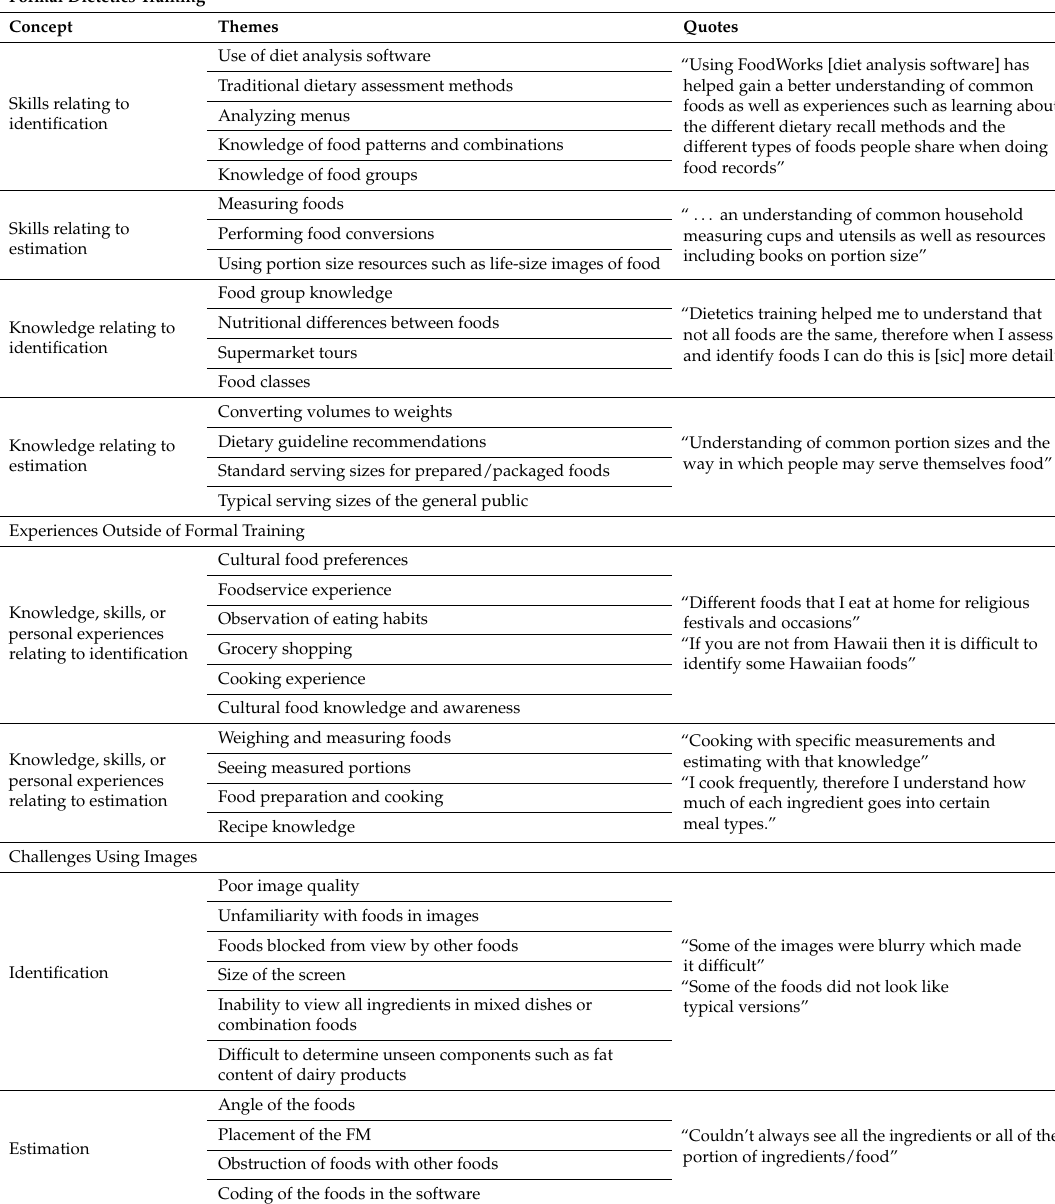
Table 1. Themes and representative quotes about image-based dietary intake assessment (IBDA) ability and challenges from a panel of four individuals with experience in completing